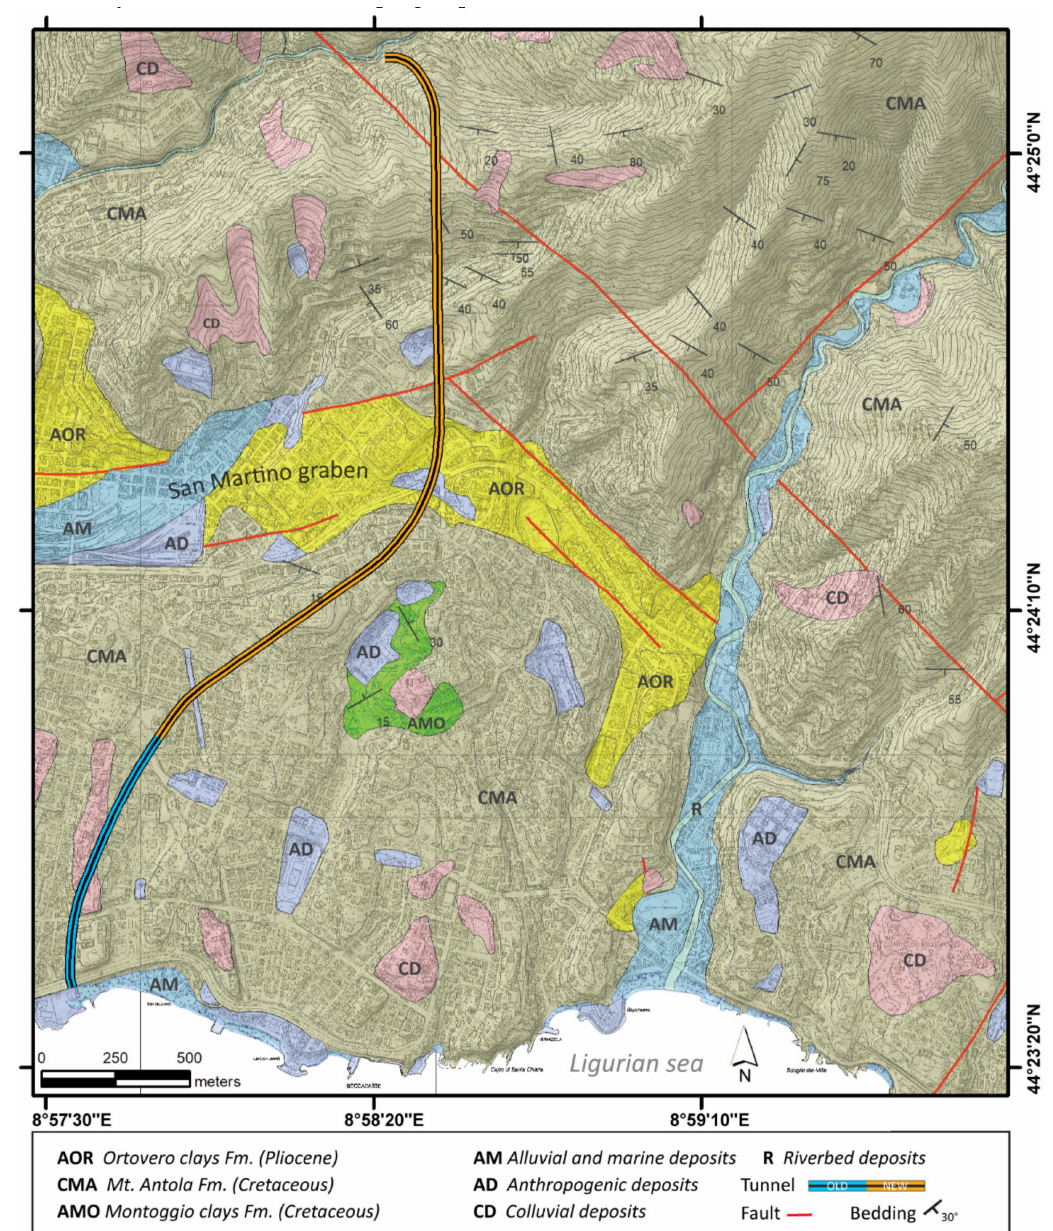
Figure 2. Geological setting of the study